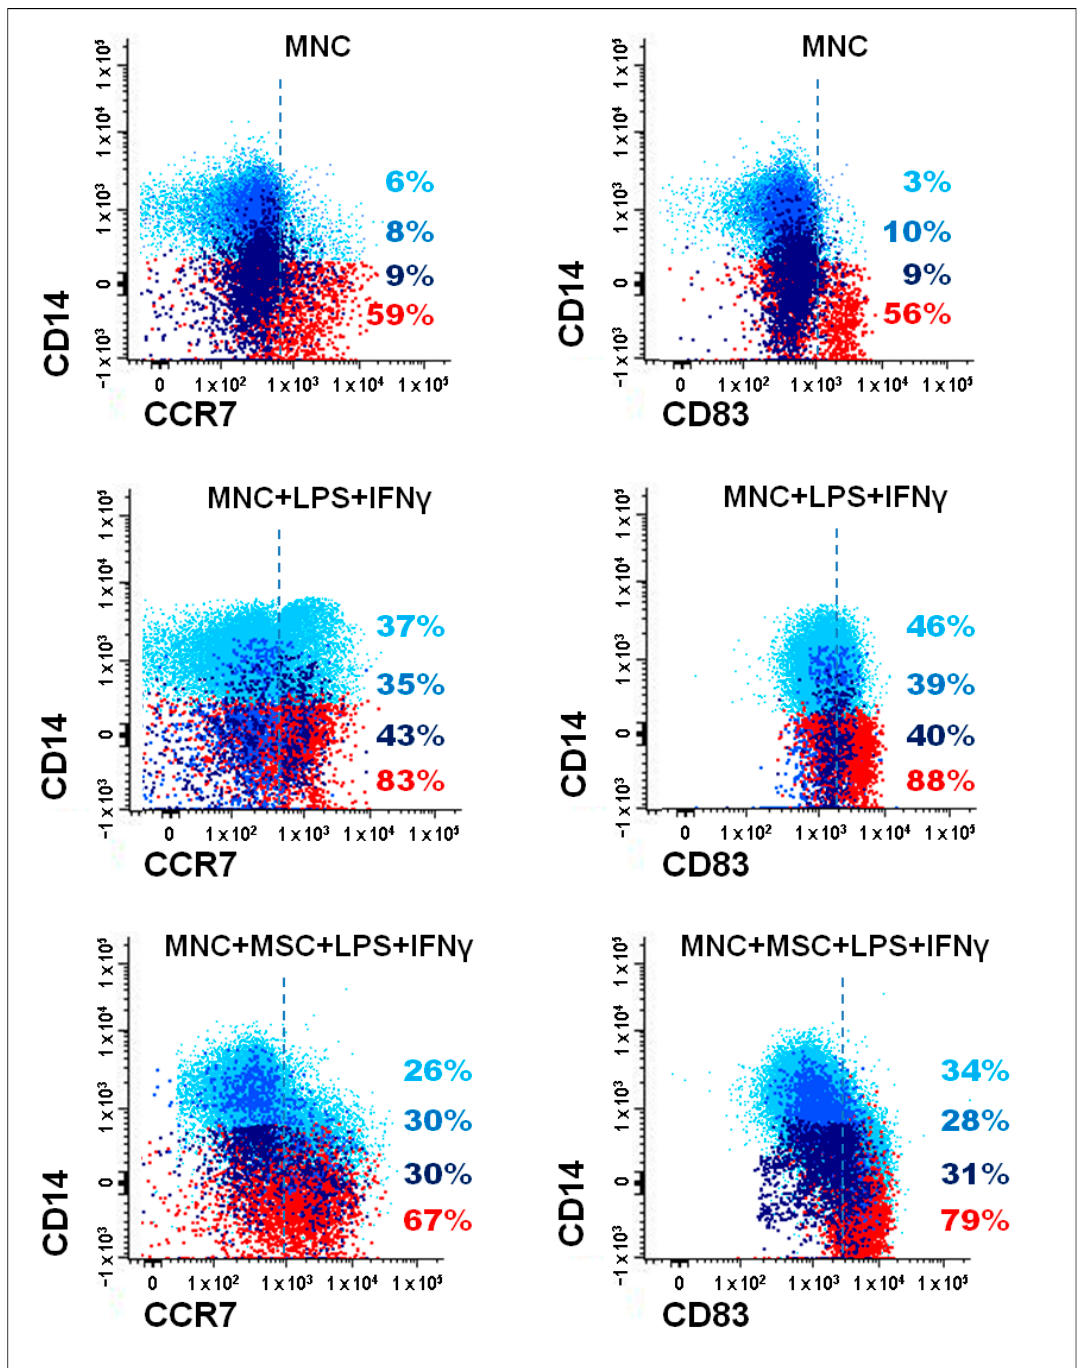
Figure 8. Percentage of CCR7 + and CD83 + cells, among classical, intermediate, and non-classical monocytes and mDCs. Bivariate dot plot histograms depicting the gating strategy to identify CCR7 + and CD83 + cells, among monocyte subpopulations and mDCs, from a RA patient. Classical monocytes correspond to light blue events, intermediate monocytes are represented in blue, dark blue events correspond to non-classical monocytes, and mDCs are represented as red events. The percentage of CCR7 + and CD83 + cells was evaluated for the three different culture conditions: unstimulated PBMCs (MNC), PBMCs stimulated with LPS and IFN γ (MNC + LPS+ IFN γ ), and PBMCs stimulated with LPS and IFN γ in co-culture with MSCs (MNC + MSC + LPS+ IFN γ ). IFN γ , interferon γ ; LPS, lipopolysaccharide; mDCs, myeloid dendritic cells; MSCs, mesenchymal stromal/stem cells; PBMCs, peripheral blood mononuclear